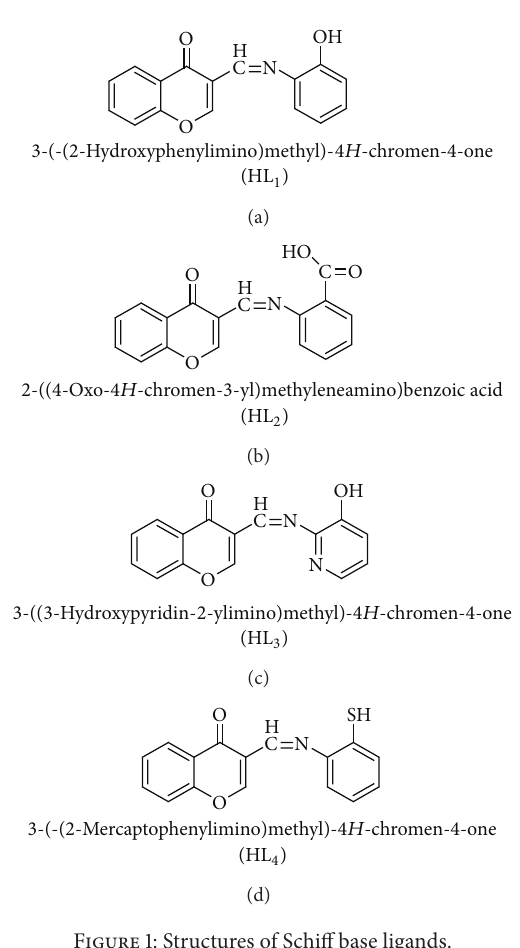
Figure 1: Structures of Schiff base